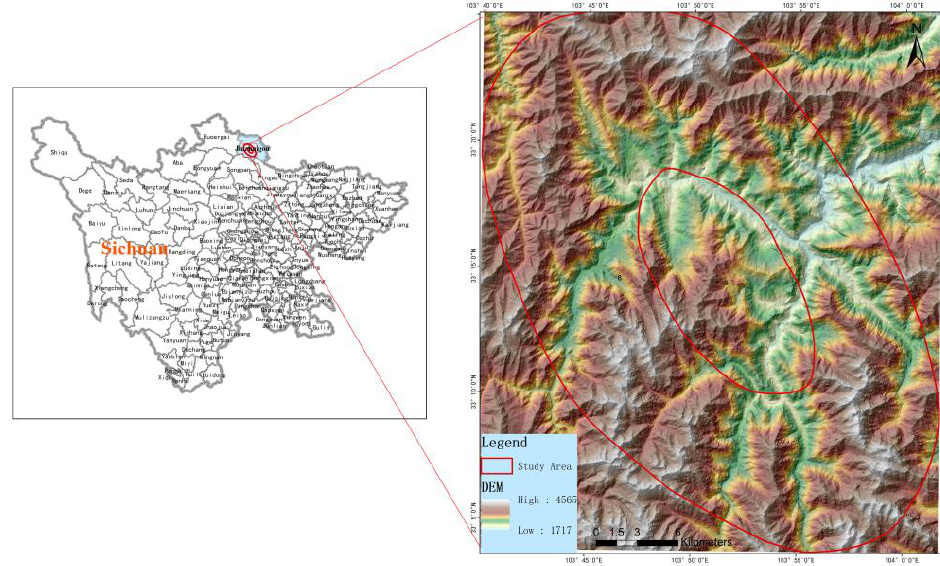
Figure 7. Topographic map of the study area.